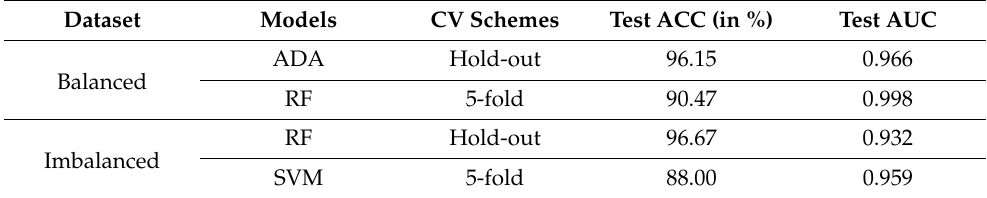
Table 9. Comparison: optimal accuracy between balanced and imbalanced datasets with different CVs.